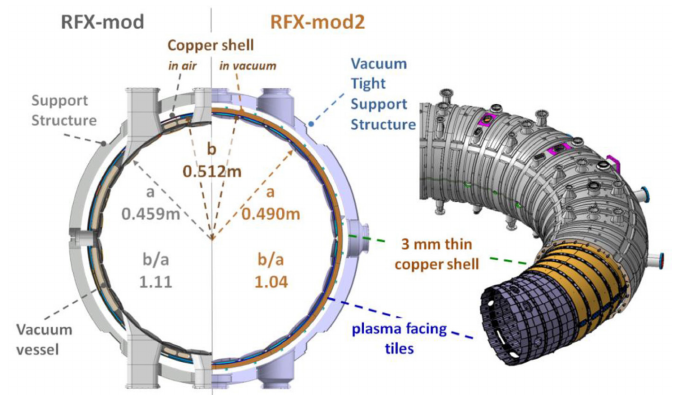
Figure 10. RFX-mod2 toroidal assembly, poloidal cross section and isometric view.